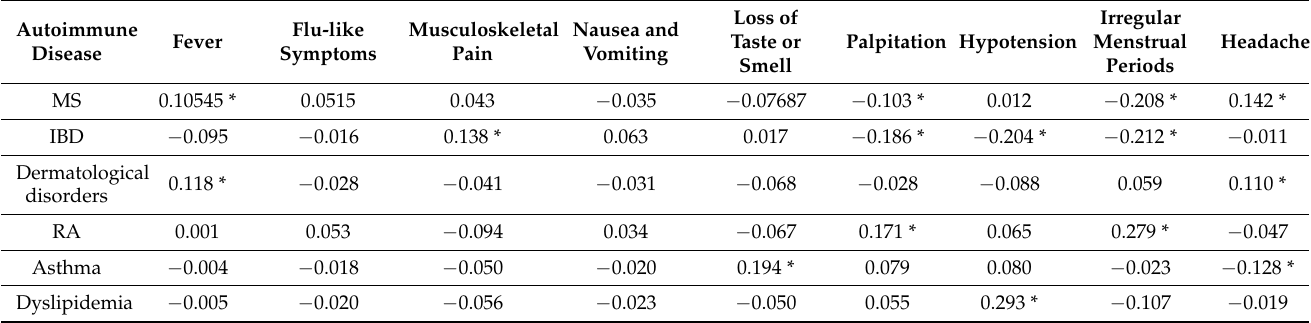
Table 3. The Pearson’s correlation coefficients (r) between different indications for the biological therapies and commonly reported COVID-19 vaccine side effects.